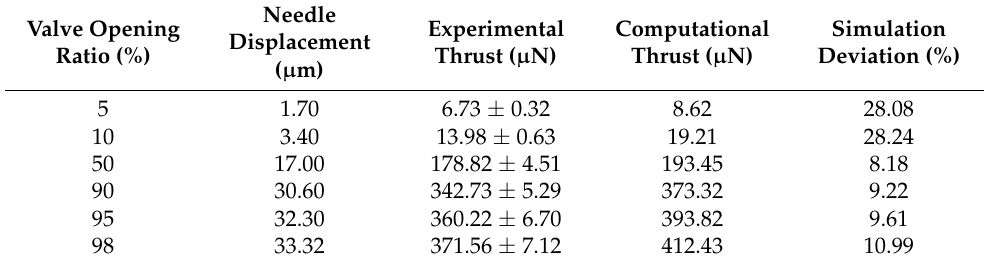
Table 2. Comparison between experimental and computational thrust